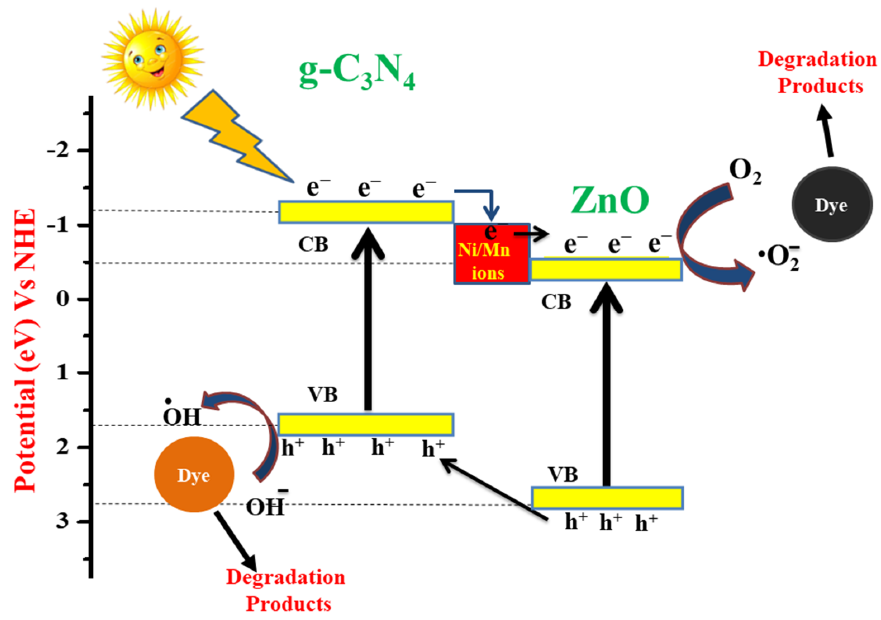
Figure 13. Mechanism of MO/EBT dye photocatalytic decoloration using Mn/GZ and Ni/GZ NCs as photocatalysts.